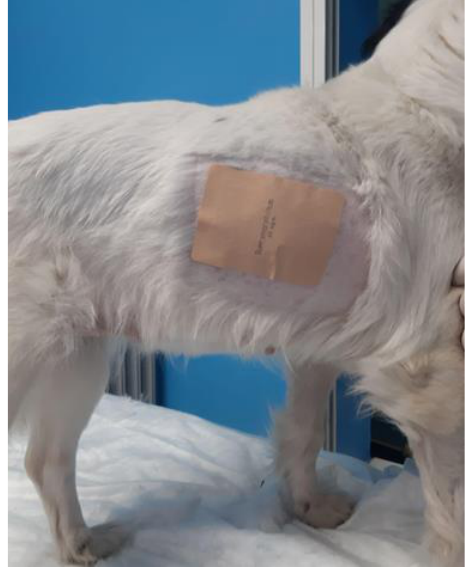
Figure 1. Placement of the TBP on the thorax after appropriate shearing and washing of the area. BupreI group (6 dogs): After the placement of the venous catheter, 30 min before the induction of general anesthesia, 20 μg/kg of buprenorphine (Buprefelican; Le Vet Beheer ® , Dechra Veterinary Products S.r.l) was administered through IV. Moreover, dogs received the same dose of buprenorphine every 6 h for the next 24 h.